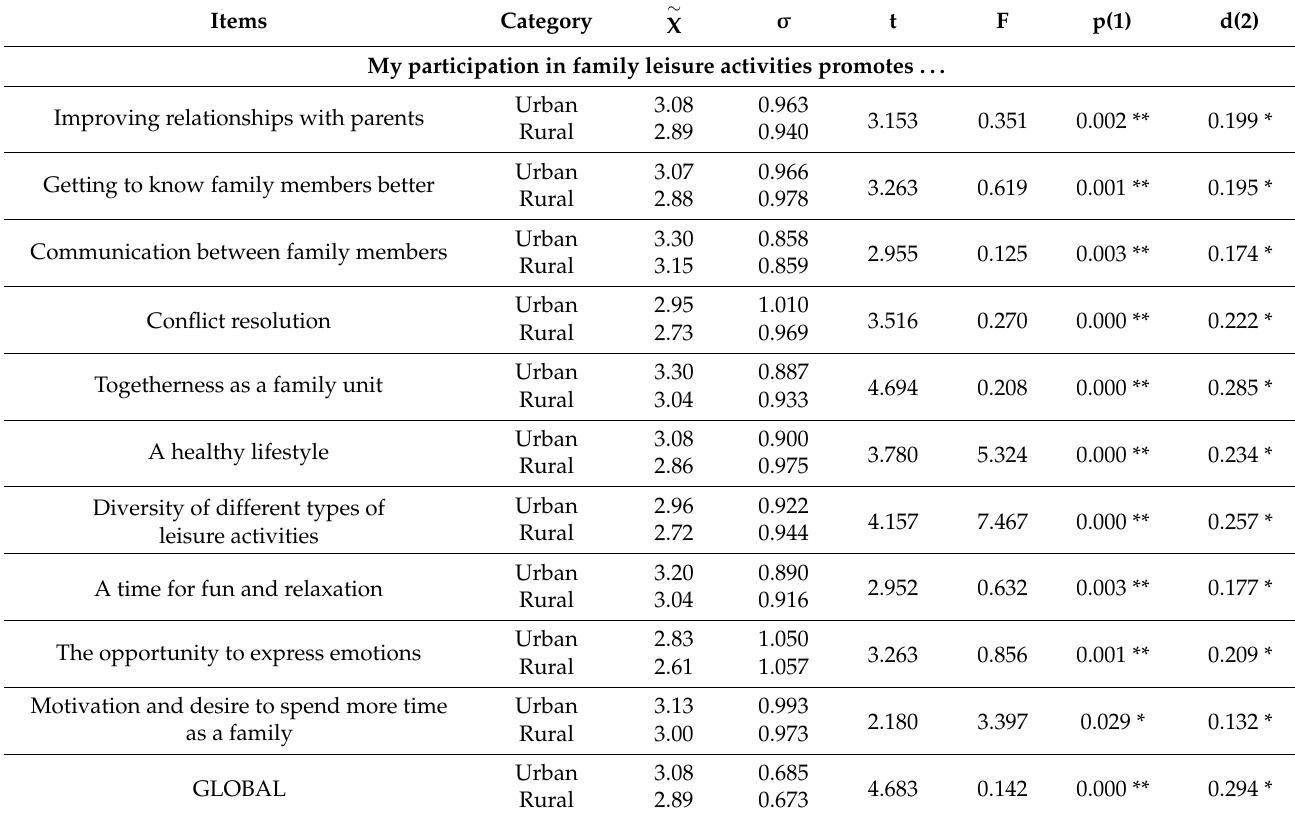
Table 3. Descriptive and inferential statistics of family leisure benefits as a function of